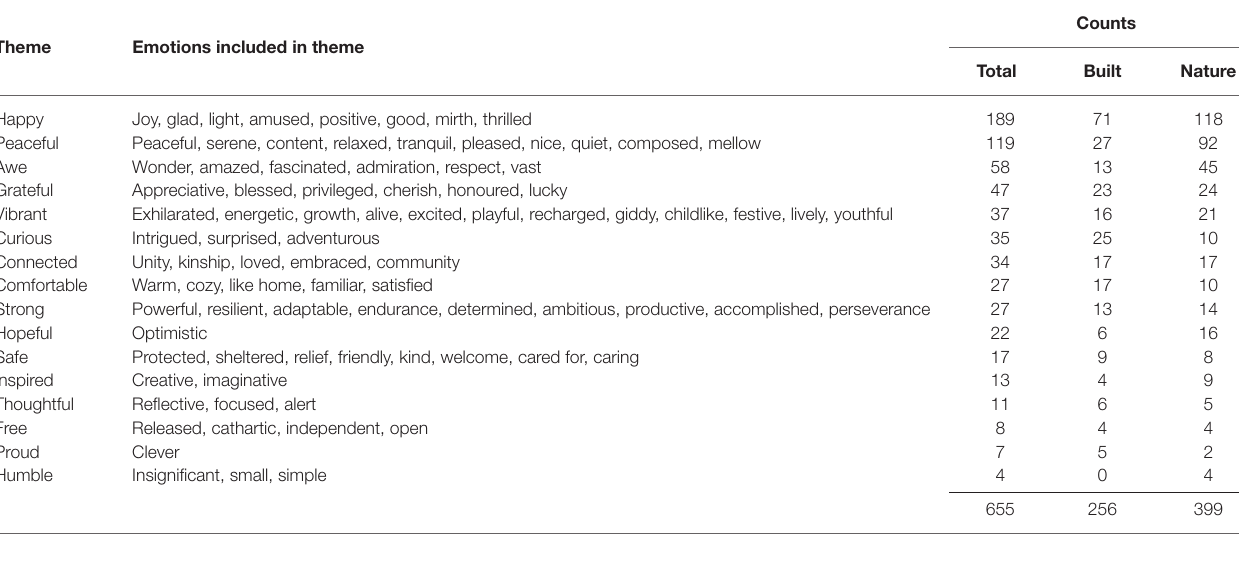
TABLE 4 | Positive emotion themes from content analysis.